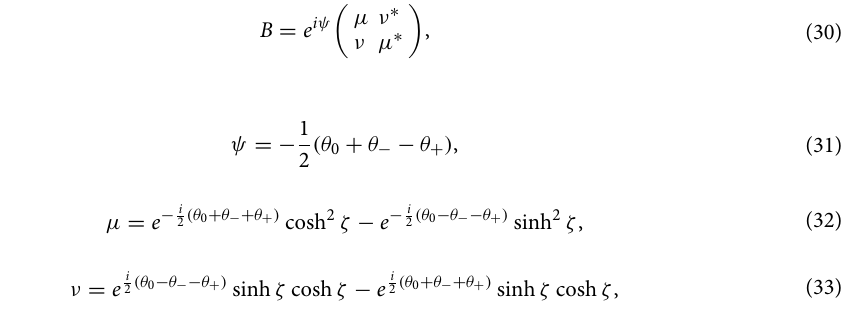
Figure 6. The dependence of the Hawking temperature T H on the relative soliton velocity u . We set the circuit parameters as L rh 4.4 10 9 Hz , and a ω s = ×